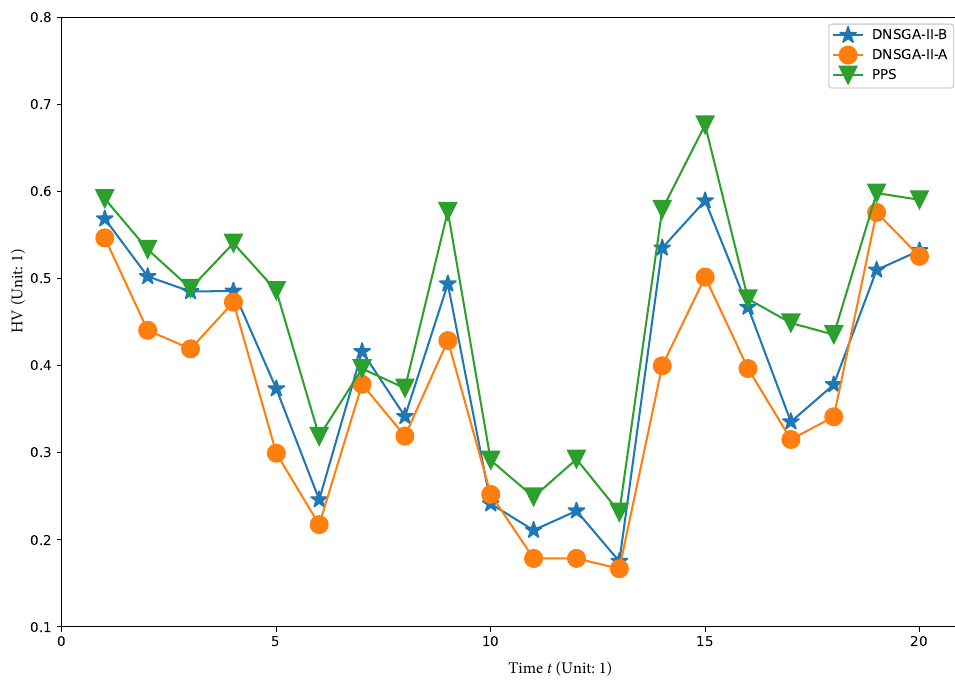
Figure 9. Obtained HV of three algorithms with τ t = 30.